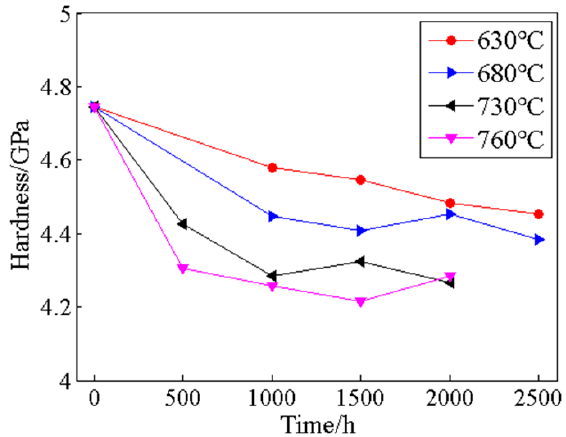
Figure 6. The variations of the average nanoindentation hardness of alloy during thermal exposure.